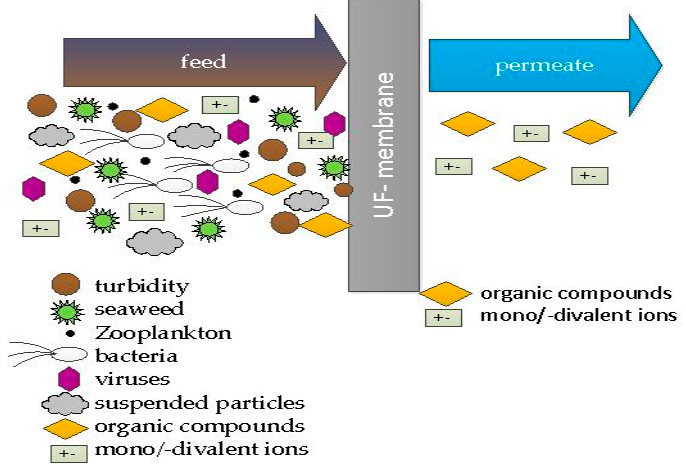
Figure 2. A schematic representation of the retention effect of ultrafiltration membranes.